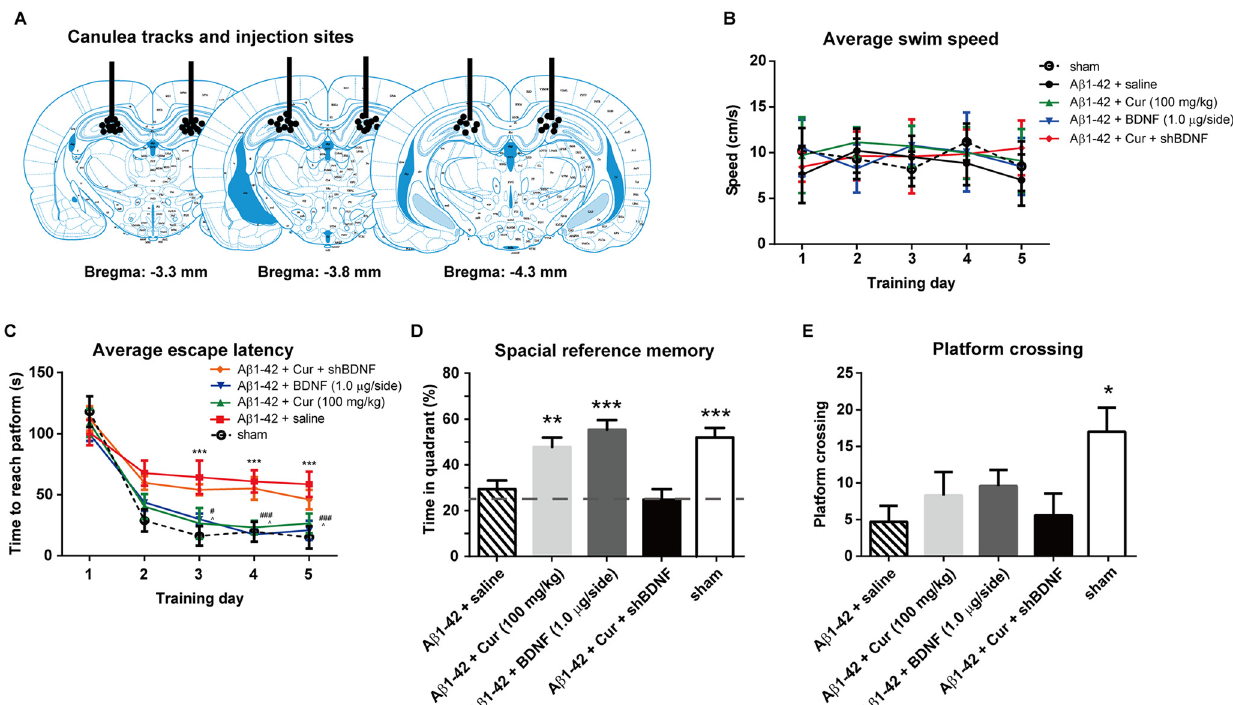
Fig 5. Effect of intra-hippocampal injections of BDNF protein or lentiviral-shBDNF on spatial learning function in the rat model of Alzheimer's disease. (A) Schematic representation showing the approximate location of microinjections into the VLO. Only rats with injection cannula tips located bilaterally in this site were included. (B) Swim speed in each training trial. (C) The escape latency during the water maze training trials. (D) The time spent in the target quadrant and (E) the number of times crossing the platform in the probe task. n = 8/group. For panel C, *** P < 0.0001, A β 1 – 42 + saline vs sham; # P < 0.05, ### P < 0.0001, A β 1 – 42 + BDNF vs . A β 1 – 42 + saline group; ^ P < 0.05, A β 1 – 42 + Cur vs . A β 1 – 42 + saline group. For other panels, * P < 0.05, ** P < 0.01, *** P < 0.0001 compared with A β 1 – 42 + saline.